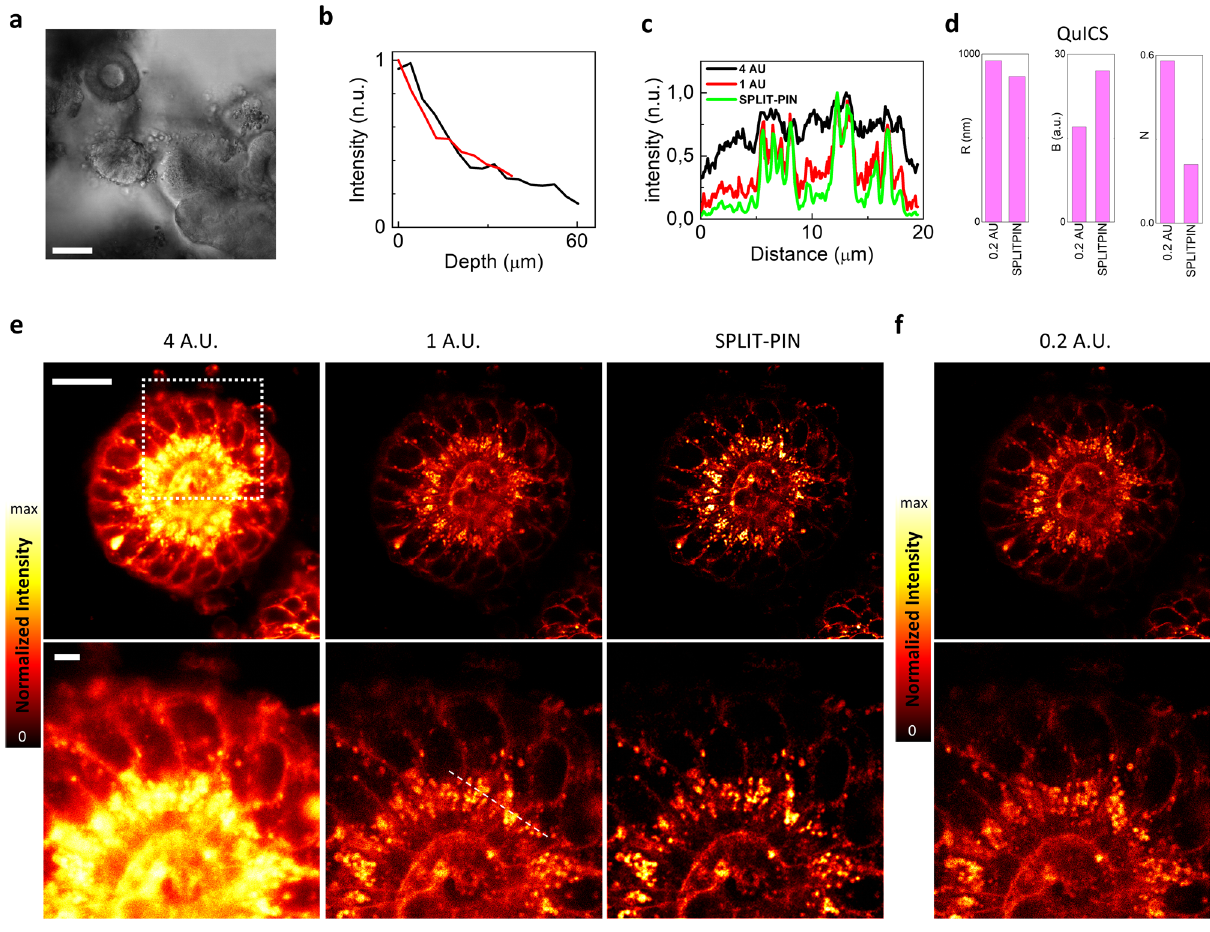
Figure 4. SPLIT-PIN imaging of live human intestinal organoids. ( a ) Bright field image of a sample of intestinal organoids. Scale bar 50 um. ( b ) Normalized fluorescence intensity as a function of the depth within the specimen. Data are obtained from two independent measurements. ( c ) Line profiles corresponding to the dashed line in ( e ). ( d ) Quantification of Resolution (R), Brightness (B) and Noise (N) parameters for the SPLIT-PIN and 0.2 A.U. images shown in ( e ) and ( f ) using the QuICS algorithm. ( e ) Series of confocal images of intestinal organoids labeled with CellMask Orange Plasma Membrane acquired with tunable pinhole size (4 A.U. and 1 A.U. respectively) and corresponding SPLIT-PIN image. Scale bar 20 um. ( f ) Confocal image of the same area of the specimen acquired at 0.2 A.U. and with an integration time equal to the total integration time of the confocal series shown in ( e